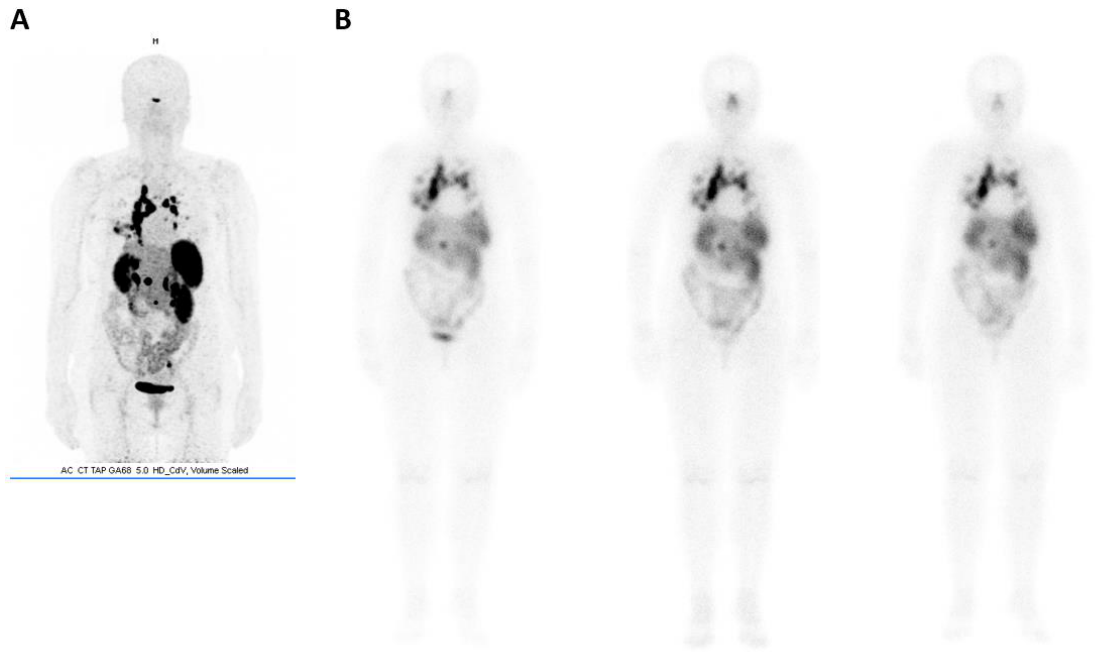
Figure 10. ( A ) [ 68 Ga]-DOTATOC (Somakit ® ) and ( B ) [ 177 Lu]-DOTATATE (Lutathera ® , cures 1, 2, and 3) imaging of a patient treated for progressive metastatic midgut NET (images courtesy of Centre Eugene Marquis, Rennes, France).